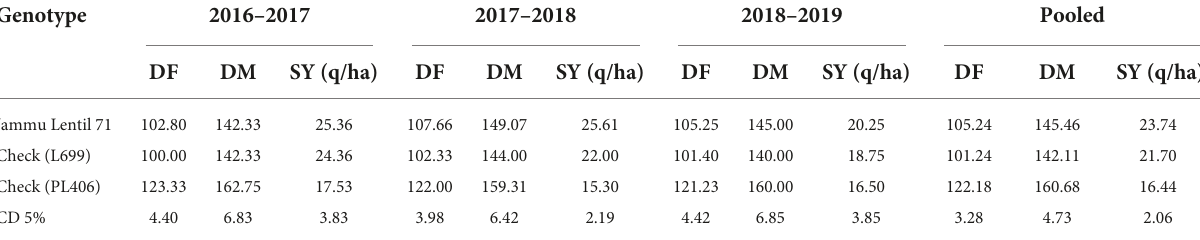
TABLE 5 Performance of selected derivative Jammu Lentil 71 along with checks during winter seasons of 2016–2017, 2017–2018, and 2018–2019.